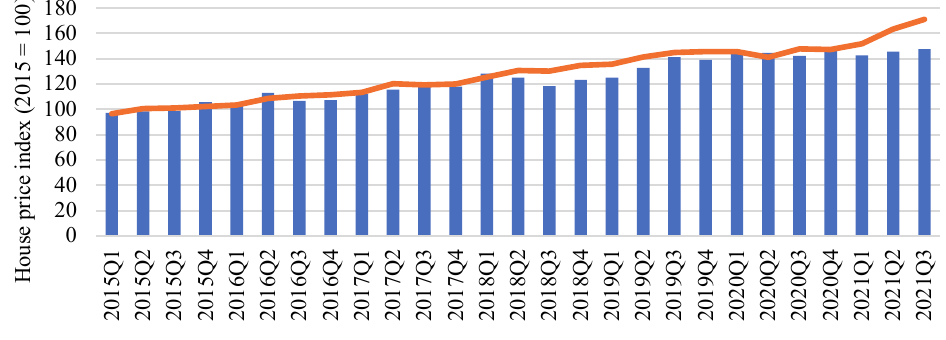
Fig. 5. House price index in the period of 2015Q1 – 2021Q3 in Latvia (2015 = 100), quarterly index (developed by the authors based on European Statistics Database